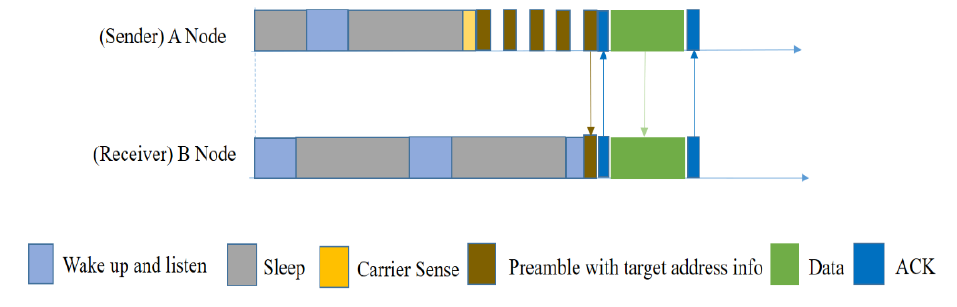
Figure 7. Packet transmission in X-MAC [30].